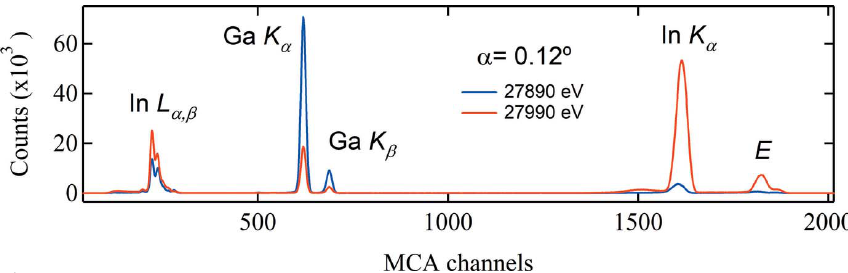
Figure 1 The MCA spectra measured below and above the In K -edge (27940 eV). The quantum efficiency of the detector is not considered (which is Ga K (cid:5) :In K (cid:5) ’